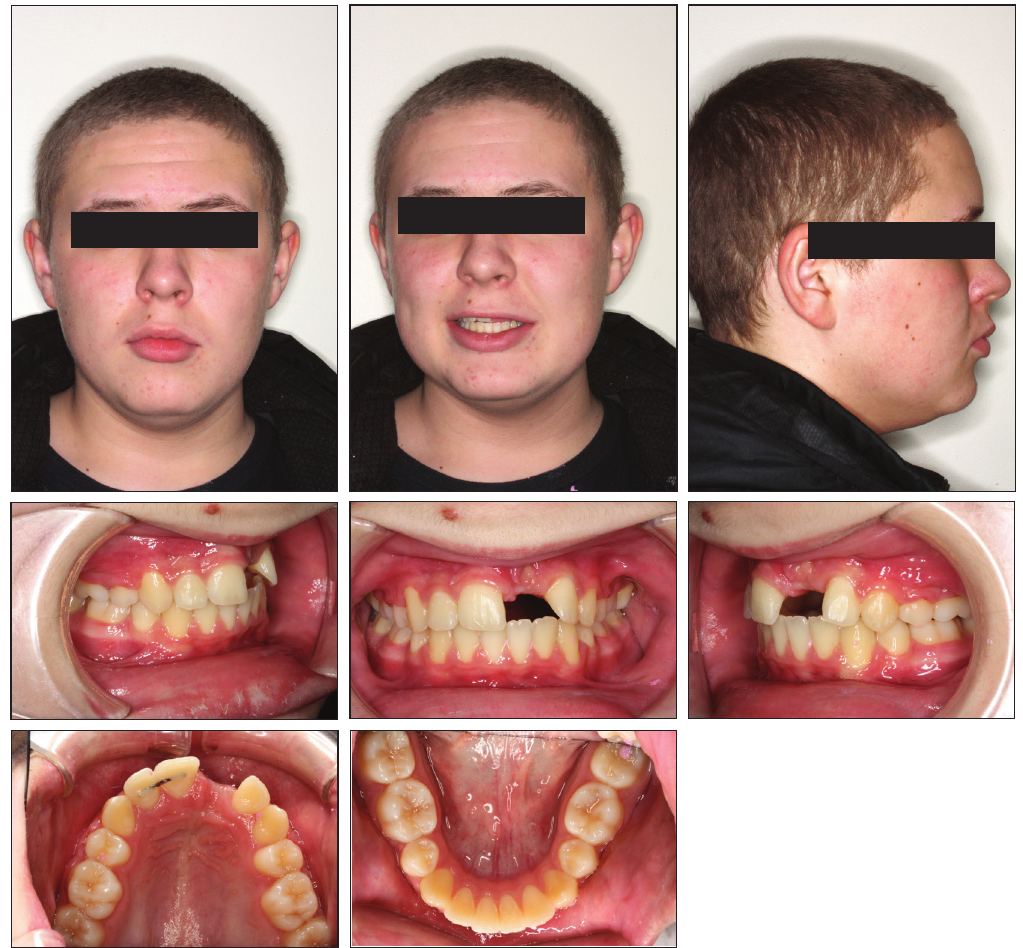
Figure 9. Post debond extra-oral and intra-oral photographs. Note the fixed retainer in situ on the palatal surfaces of upper right central and lateral incisor.